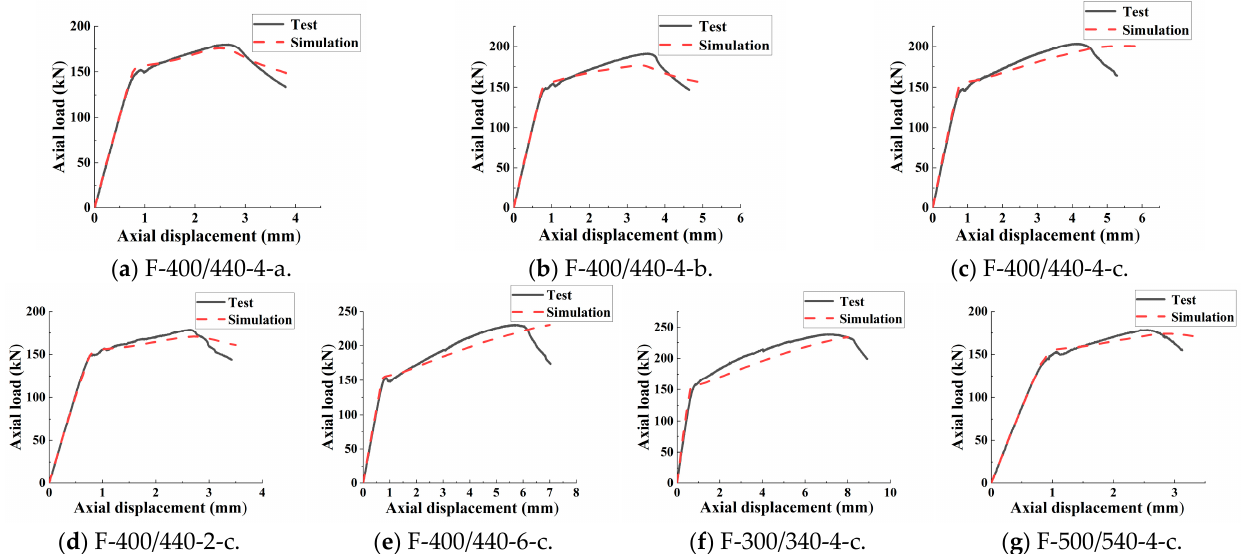
Figure 9. Load–displacement curve comparison for FCCC-R specimens. Table 6. Comparison between the test value and the simulation value of peak loads.